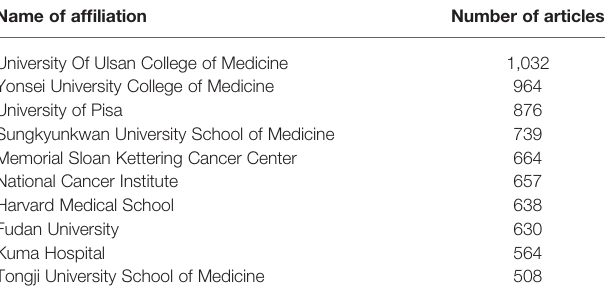
TABLE 1 | Top 10 af fi liations with highest scienti fi c